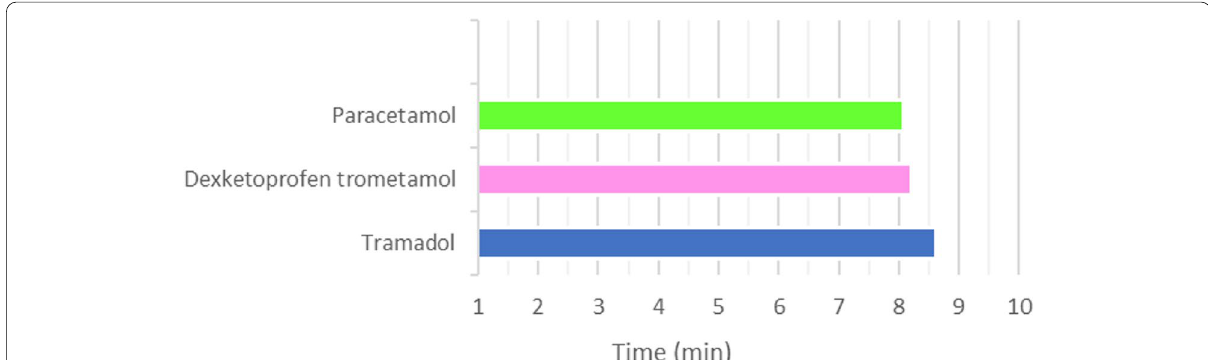
Fig. 3 Graphical presentation of recovery time to Aldrete recovery score point 10 (min). Data are mean (SD), p comparisons, min, minute